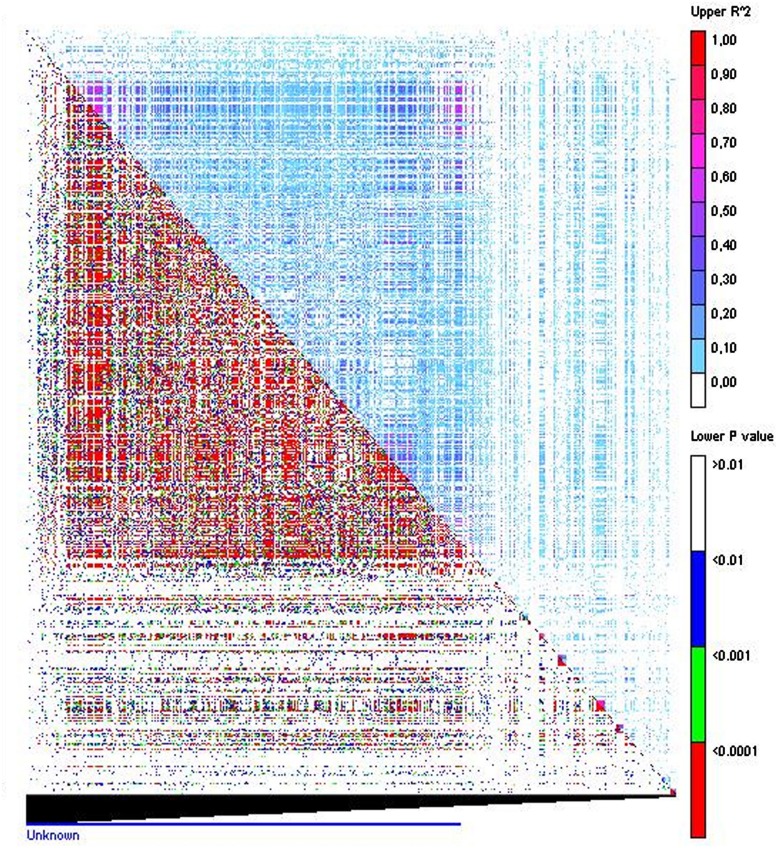
Linkage disequilibrium matrix. Pair-wise LD values of polymorphic sites displaying r2 above the diagonal and the corresponding p-values from rapid 1000 shuﬄe permutation test below the diagonal. Each cell represent the comparison of two pairs of marker sites with the color codes for the presence of significant LD. Colored bar code for the significance threshold levels in both diagonals is shown.